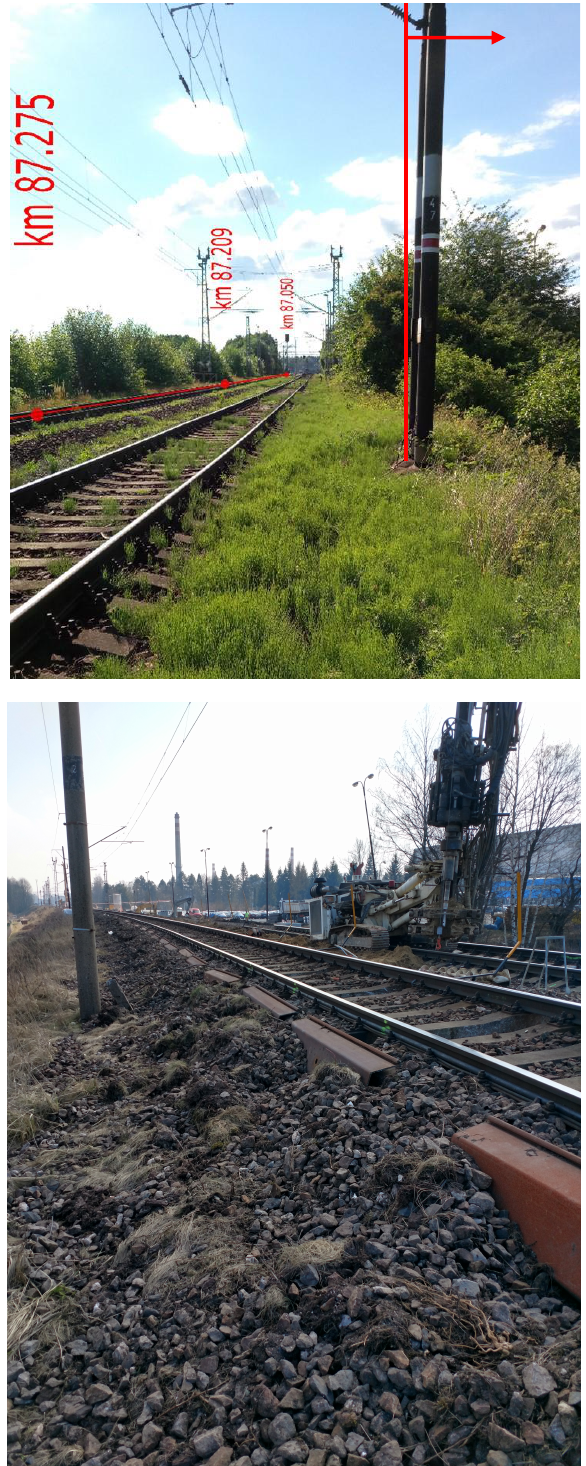
Figure 1. Condition of the railway before recon- struction: tilting of the traction line columns (top) and Temporary measures against disintegration of the track rail geometrical position(bottom). (1.) Removal of the top part of the embankment along its entire length to a depth of approximately 1.6 m below the current sub-ballast layer. (2.) Construction of the Deep Soil Mixing